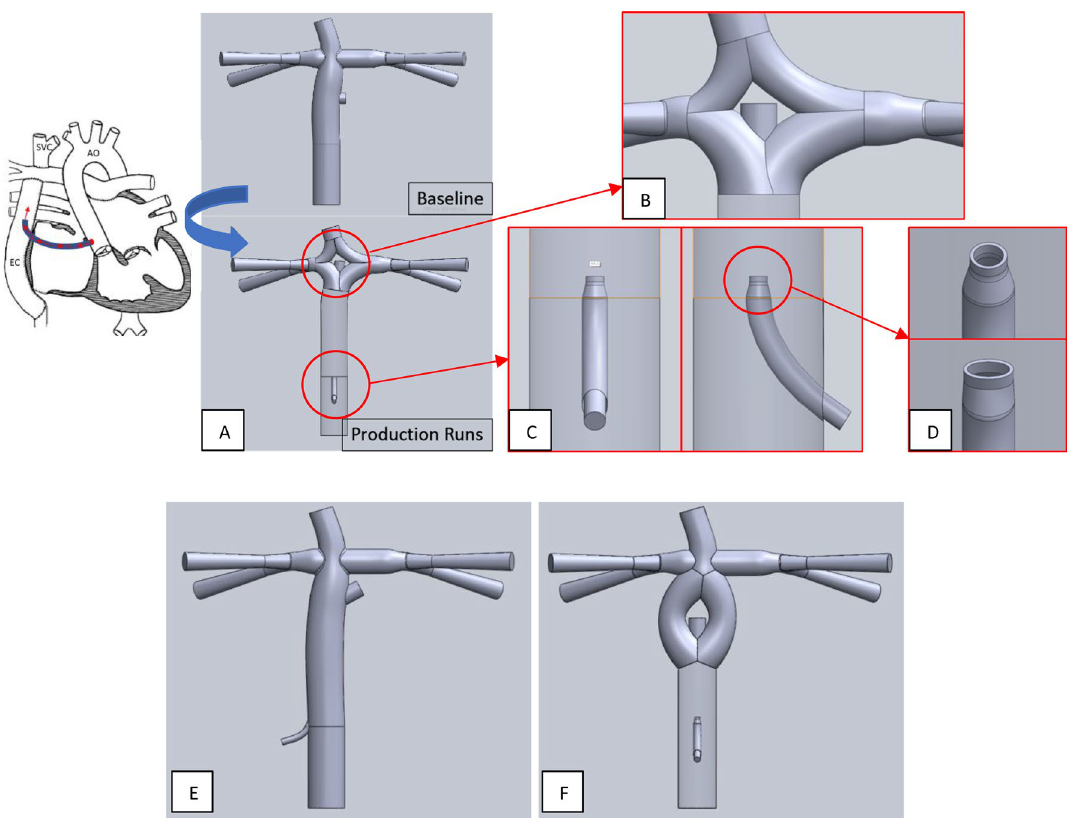
Figure 1. ( A , B ) Example geometric alteration of a traditional fenestrated Fontan (baseline) to create a double Y-graft (2Y) connection with the IJS and a fenestration at the bifurcation; ( C ) single nozzle IJS in the Fontan conduit with ( D ) variable nozzle shape (circular (top) and high aspect-ratio elliptical mouth (bottom)). A 2 mm IJS nozzle and a 8 mm fenestration are combined in ( E ) a skew configuration where the jet originates at a shallow angle pointing to a lateral fenestration and ( F ) a torus configuration that retains the centerline-aligned fenestration in the cusp of the bifurcation. Note that the bifurcating connection between the superior